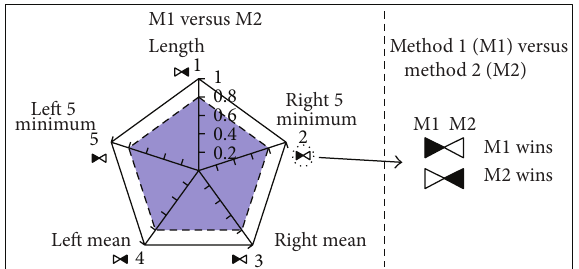
Figure 4: Developed visualization method.